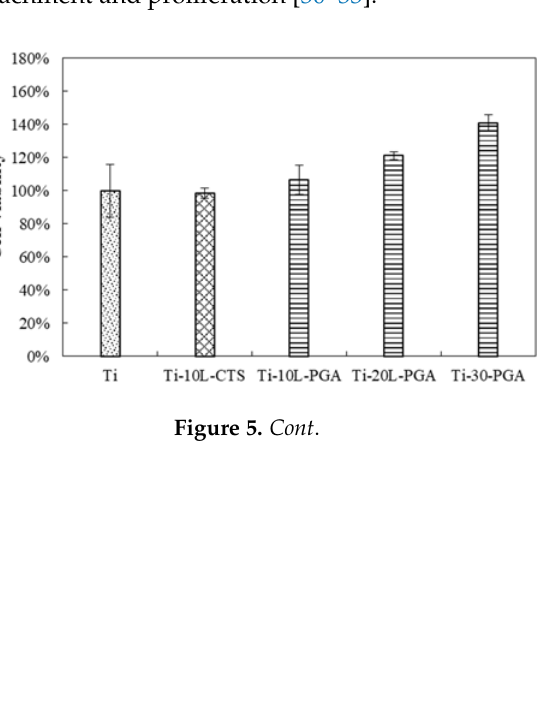
Figure 5. The cell viability of MG63 seeded on ( a ) Ti6Al4V substrate and ( b ) 316LSS substrate with different layers of PEMs coatings were measured using MTT assay. The bare metal substrate was used as the control. *: p < 0.05 compared to bare Ti6Al4V or 316LSS substrate. A more direct method to observe the cell adhesion and affinity on a material is to observe cell attachment and morphology using fluorescence microscopy. MG63 cells seeded on different layers of C/PGA PEMs coating on Ti6Al4V and 316LSS substrates for one and three days are depicted in Figures 6 and 7. At the first day (Figure 6), both bare metal substrates and PEMs coated specimens show minimal cell adhesion. Only a few MG63 cells were found on the specimens with PGA as the outer layers. After three days of culturing, both bare metal substrates and PEMs coated specimens demonstrate different degrees of cell attachment as shown in Figure 7. More MG63 cells were observed on bare 316LSS surface as compared to bare Ti6Al4V. The PEMs coated specimens with chitosan as the outer layer show similar affinity of cell adhesion as bare metal substrates, which is in coherence with the cell viability result. Polymeric materials are known to hinder fluorescence imaging due to either autofluorescence or light scattering property of polymers [34]; thus, it is not possible to clearly identify the cells on PEMs coated specimens with PGA as the finishing layer in this experiment. Figure 6. Fluorescence microscopy images of the MG63 cells seeded on different layers of C/PGA on Ti6Al4V and 316LSS substrates for one day and stained with Hoechst 33258. The scale bars are labeled in white with the length of 100 μ m.